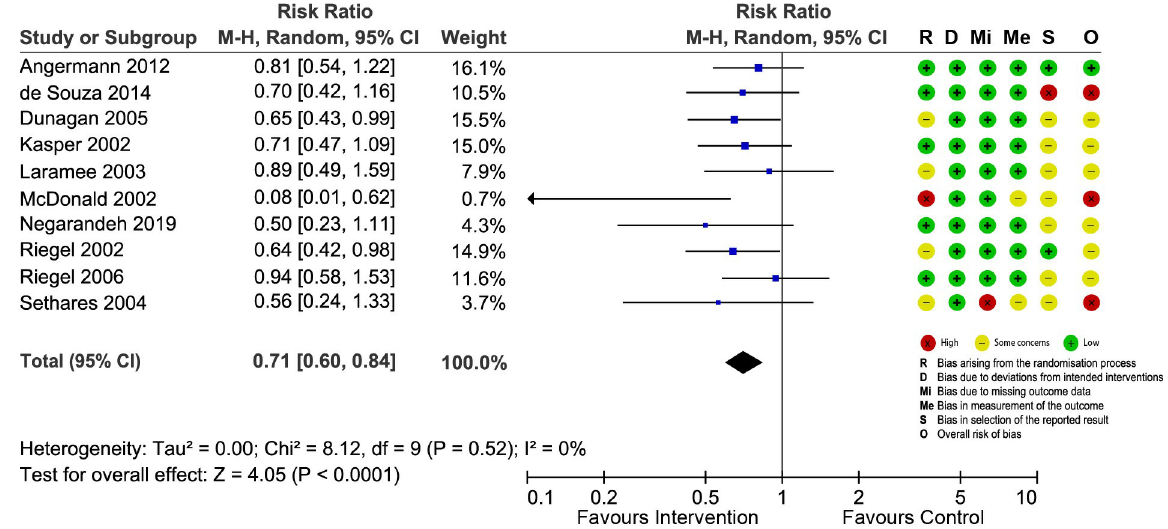
Fig 3. Forest plot showing the effect of nurse-led TCIs on HF-specific readmissions and risk of bias assessment for each study.